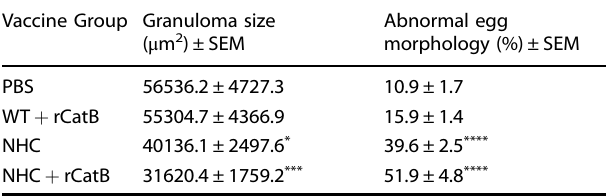
Table 1. Granuloma size and egg